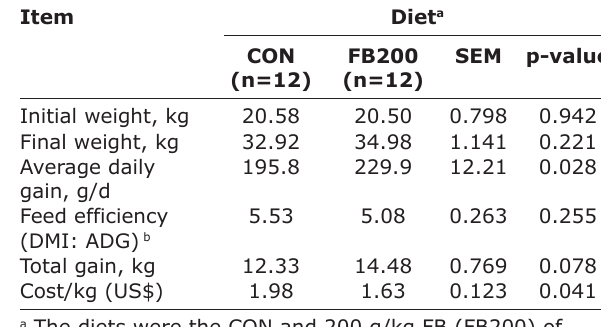
Table-4: Growth performance of Awassi lambs fed diets containing